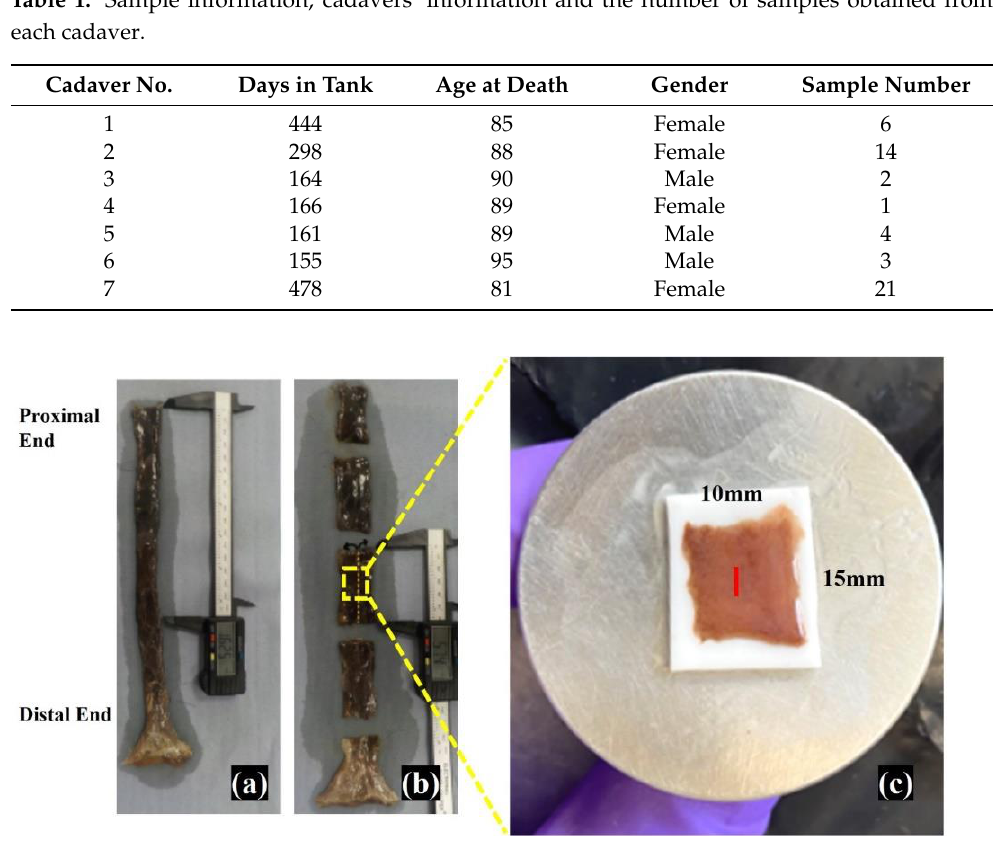
Figure 2. The oesophagus was shown in ( a ), it was divided into five same length sections. ( b ) The gastro – oesophageal transition zone is selected for the OCT/OCE examination. ( c ) indicates that a sample with 15 mm (Longitudinal) and 10 mm (Transverse) was incised off from the gastro–oesophageal transition zone sample. The sample was placed on the sample holder with silicone reference material (White) underneath it. A red line on the sample indicates the OCT/OCE scan position.